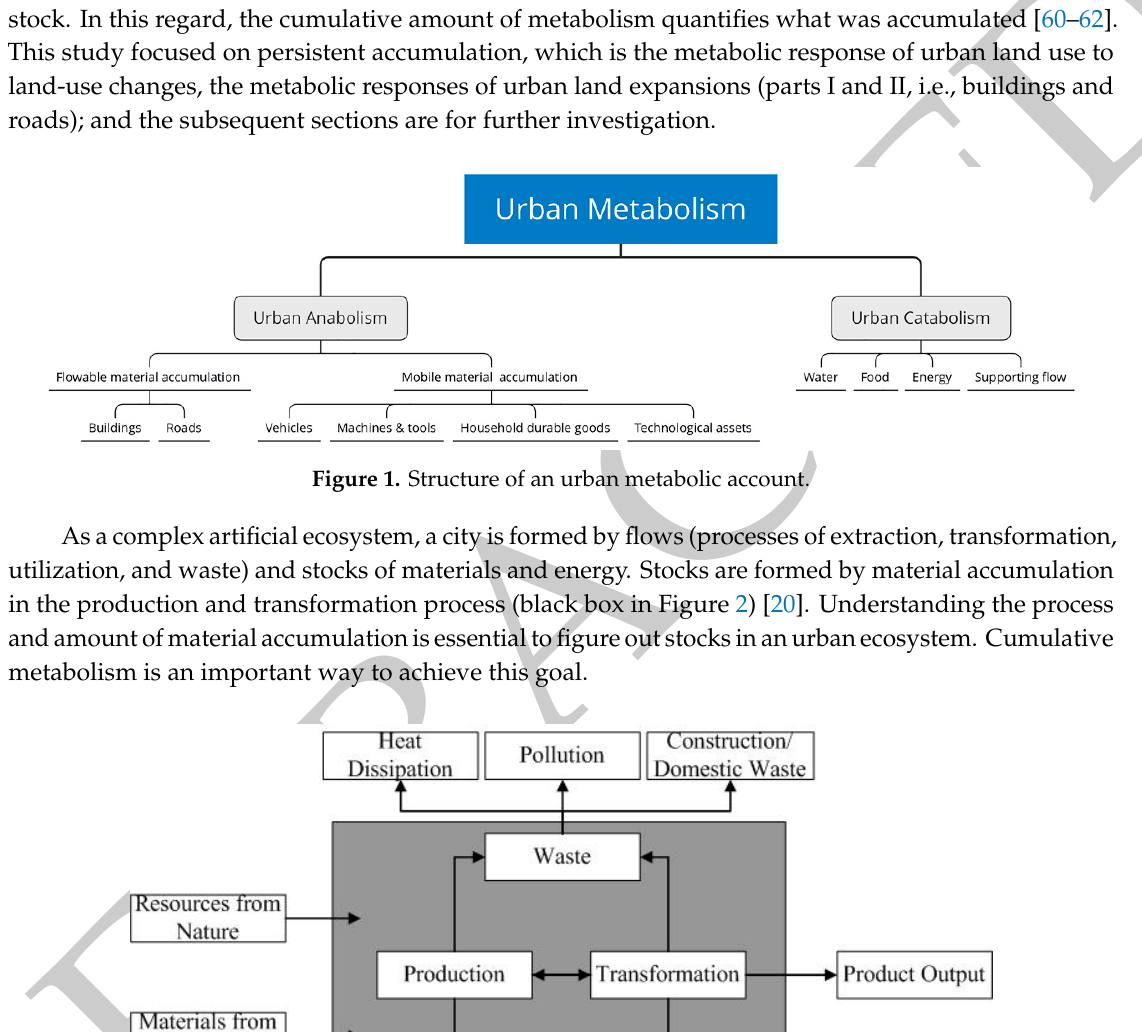
Figure 2. Material-accumulation and -flow system in urban ecosystems.